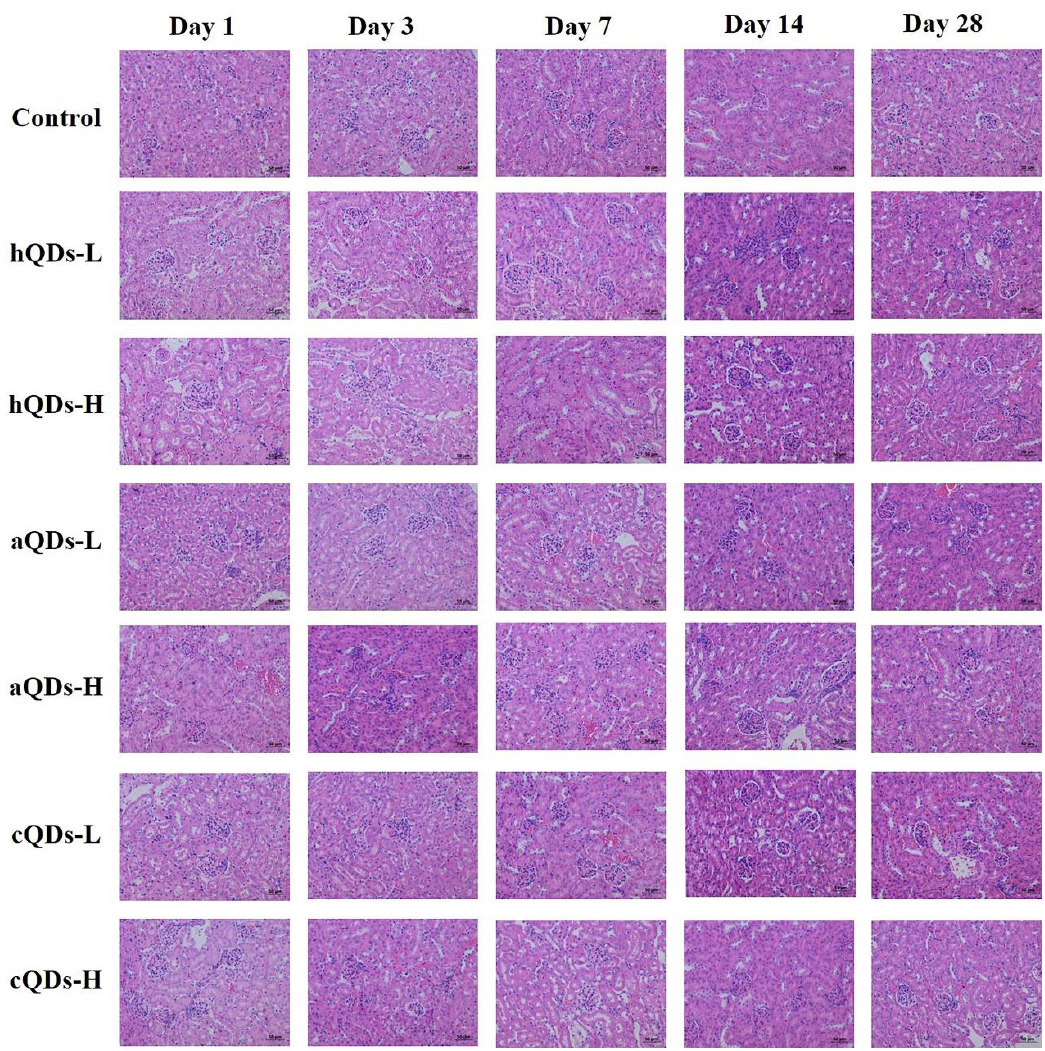
Figure 5. Representative histological images of kidney tissue from mice administered with 25 mg/kg BW QDs (H) or 2.5 mg/kg BW QDs (L) at different predetermined time points ( scale bar: 50 μm ).